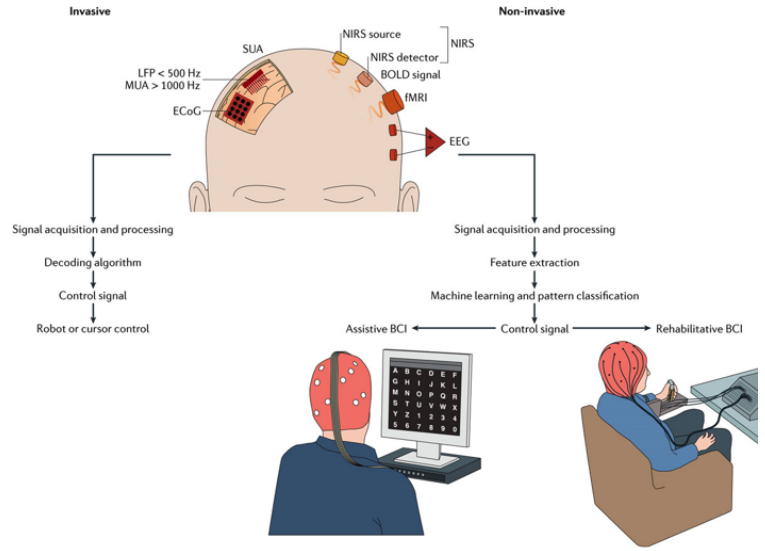
Figure 2. The acquisition techniques